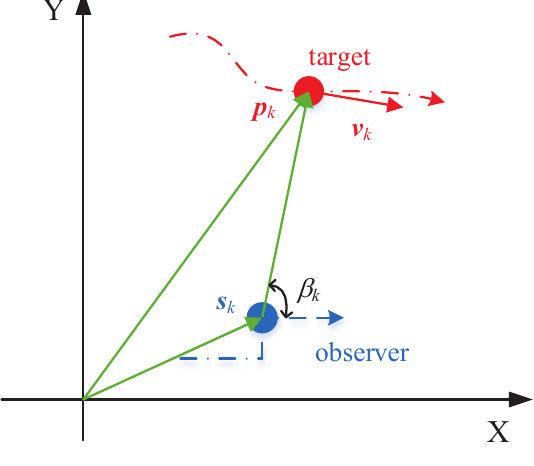
Figure 1. Geometry for 2-D BOT